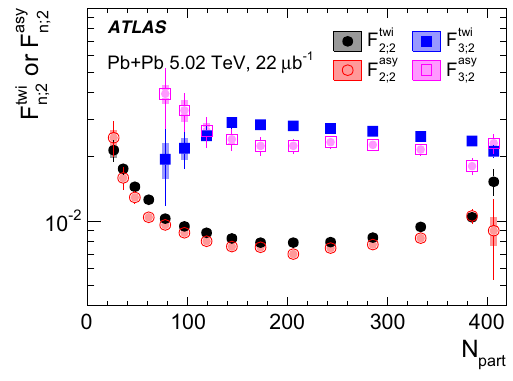
Fig. 20 The estimated event-plane twist component F twi and FB n ; 2 asymmetry component F asy as a function of N part for n = 2 and 3 n ; 2 for Pb+Pb collisions at 5.02 TeV. The error bars and shaded boxes are statistical and systematic uncertainties,